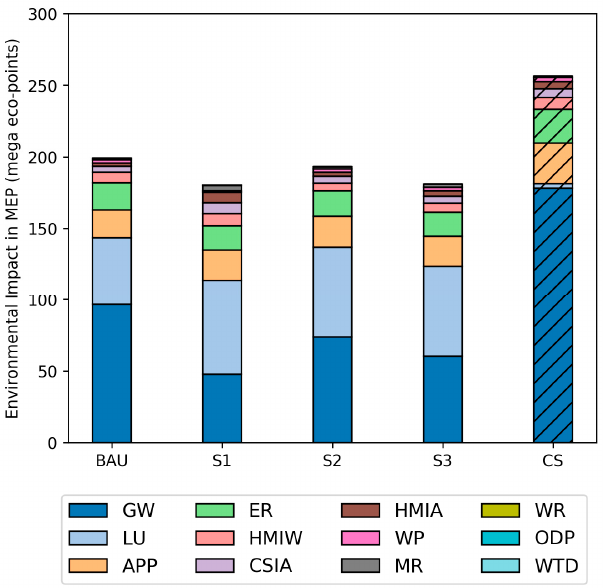
Figure 4. Scenario Impacts with ESM ENsource, GW = global warming, LU = land use, APP = main air pollutants and PM, ER = energy resources, HMIW = heavy metals into water, CSIA = carcinogenic substances into air, HMIA = heavy metals into air, WP = water pollutants, MR = mineral